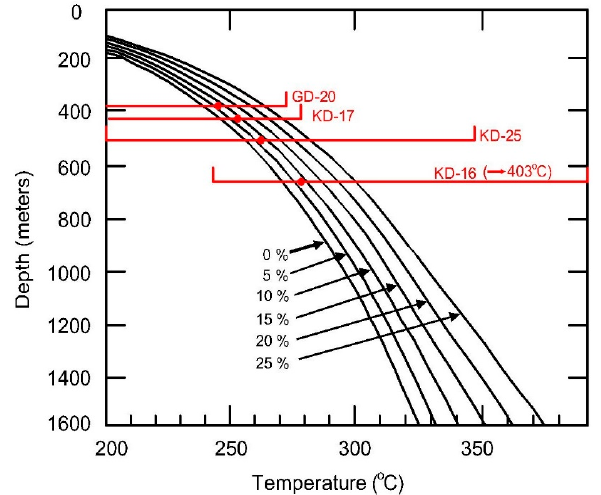
Figure 11. Temperature vs. depth diagram with boiling-point curves for H 2 O liquid (0 wt %) and for brine of different compositions given in wt % NaCl. The temperature at 0 m of each curve is the boiling point for the liquid at 1.013 bars (1.0 atm) load pressure [47].